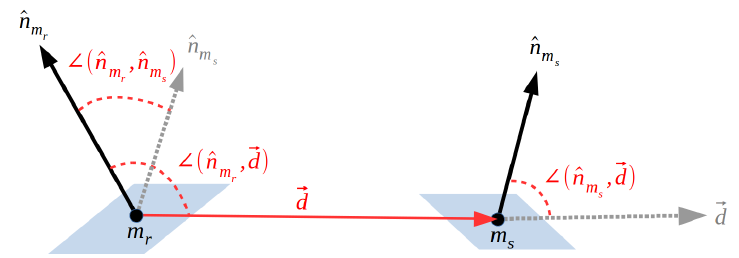
Figure 1. The Point Pair Feature definition for a model’s point pair ( m r , m s ) .